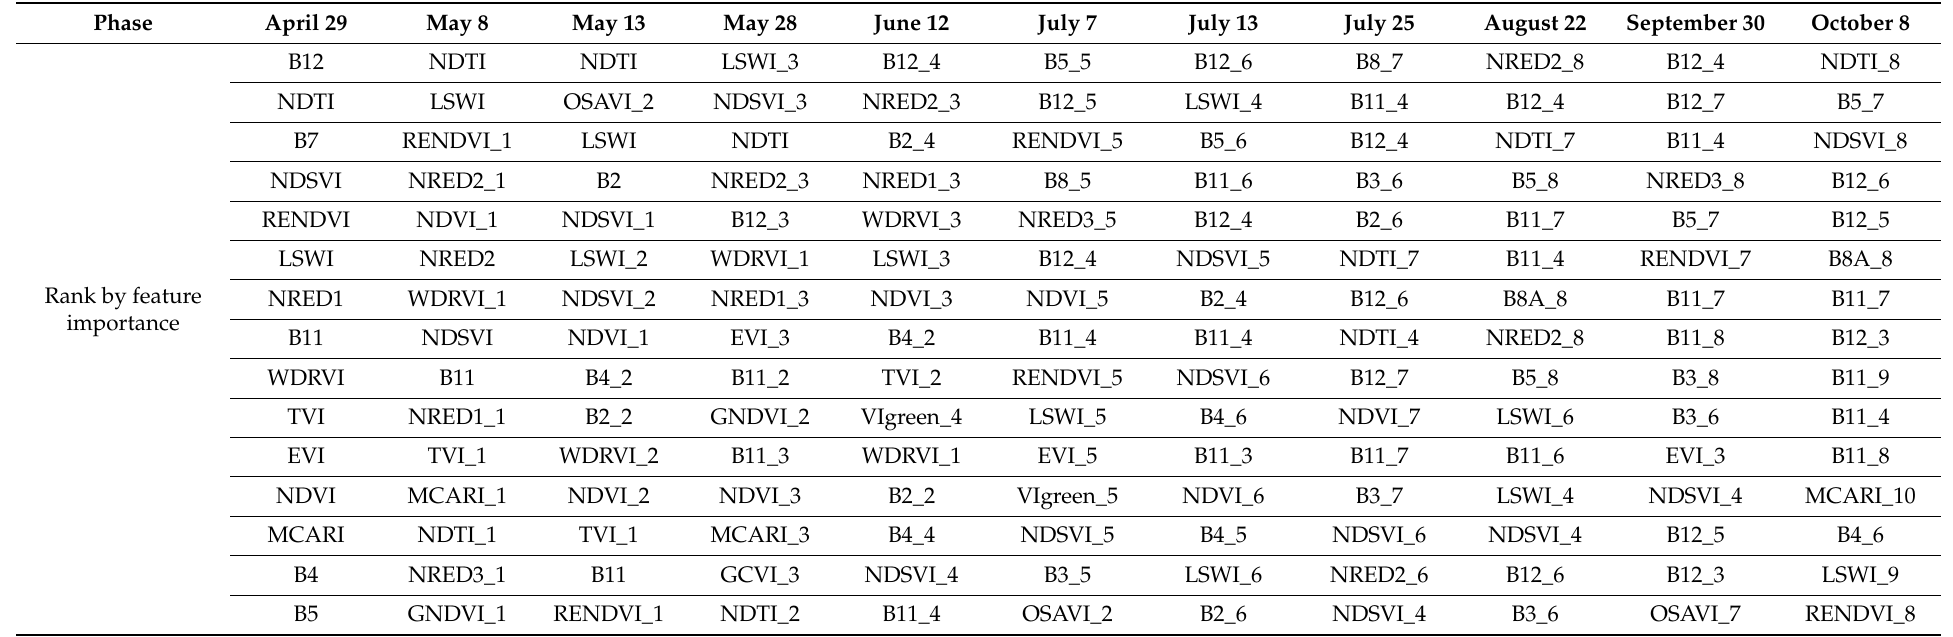
Table A1. Optimal feature sets at different periods in